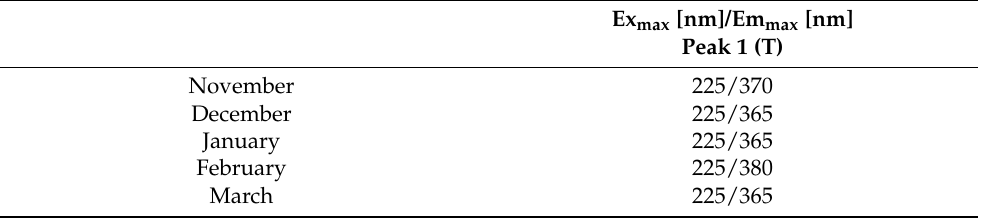
Table 4. The wavelength-independent fluorescence maximum ( λ Ex / λ Em ) changes for the main peak T—linked to tryptophan-like seawater components—for particular months (November-March) in the winter season in the Baltic Sea.